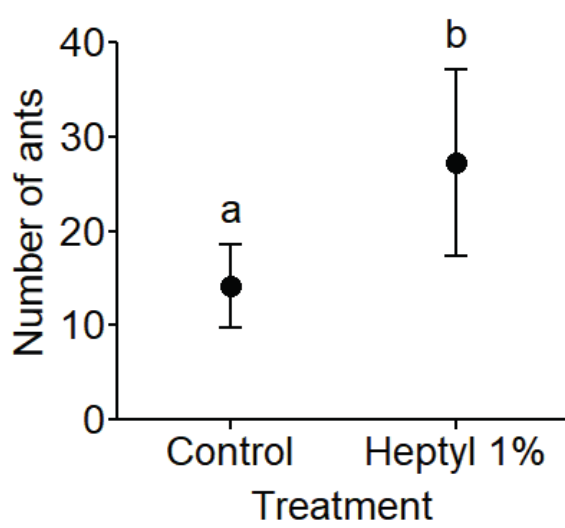
Figure 1 - Number of ants (mean ± SE) walking during 1 min through filter paper impregnated with ethanol (control) or heptyl butyrate 1%. Different letters indicate significant differences (p < 0.05, N = 10).